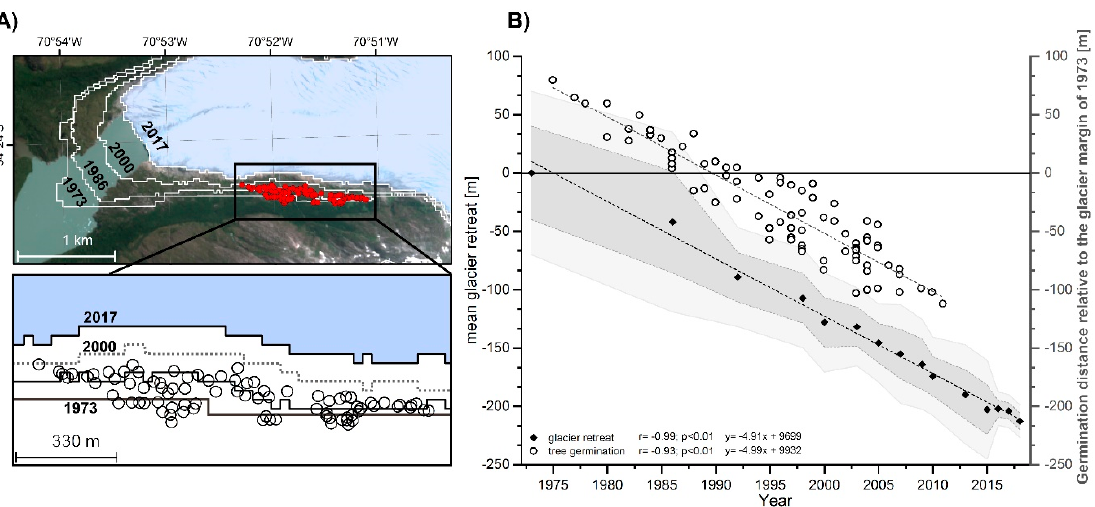
Figure 5. ( A ) Geolocation of the sampled trees at the southern lateral moraine in relation to the glacier’s margins between 1973 and 2018 (background Sentinel-2, 03-08-2017). ( B ) Mean glacial retreat along the lateral moraine, including tree germination as a dependency of the glacial margin in 1973. Trees with positive and negative distance values germinated outside and inside the 1973 glacial extent, respectively. Light grey and grey areas indicate the maximum possible uncertainty by comparing two glacial outlines (i.e., ±1 and ±0.5 pixel of each satellite pair to be faulty).